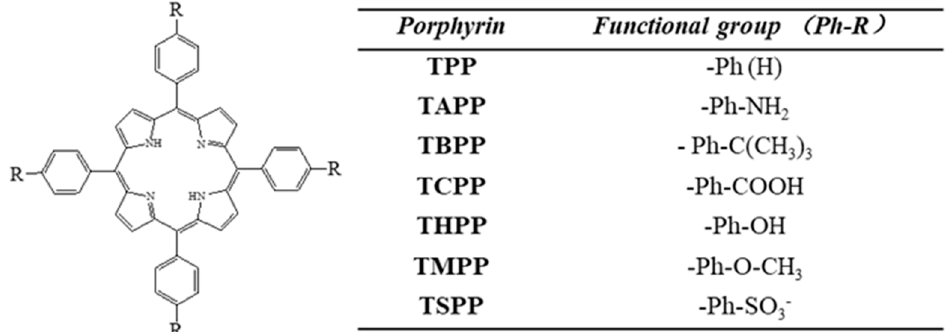
Figure 1. Chemical structure of investigated porphyrins. R = H (TPP), –OH (THPP), –tBu (TBPP), – COOH ( TCPP), –NH 2 ( TAPP), –OCH 3 (TMPP), –SO 3 − (TSPP).